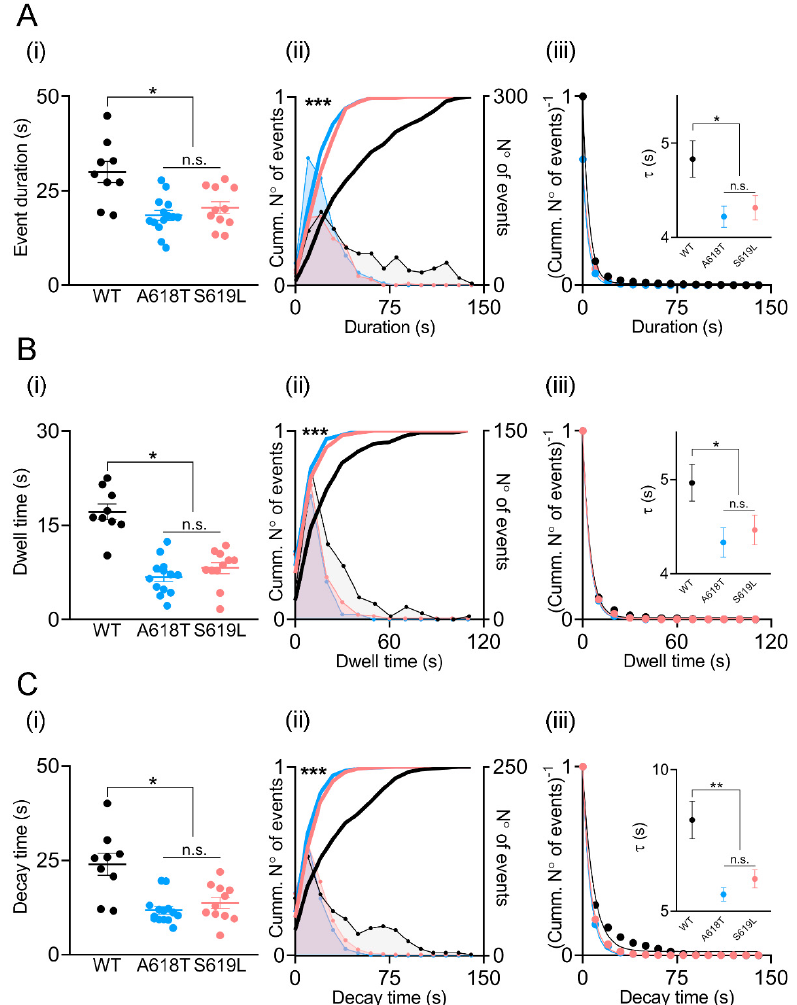
Figure 4. Kinetic parameters in C25 myoblasts overexpressing WT dynamin-2 or the p.A618T or p.S619L mutations. Analysis of event durations, dwell-time lengths and decay times in cells transfected alternatively with WT dynamin-2 (black), p.A618T (blue) or p.S619L (red). Panels (i) show average values of duration ( A ), dwell time ( B ), and decay time ( C ) from individual cells (filled dots) obtained from at least three independent cultures in each condition. Horizontal lines indicate means with SEM. The different conditions were compared by ANOVA test, followed by Bonferroni multiple comparison test * p < 0.05. Panels (ii) show the frequency distribution histograms (lines with dots; 10-s bin widths calculated using the Freedman–Diaconis rule) and its corresponding cumulative histograms (continuous lines) of events obtained during the recording period. The cumulative histograms of mutants vs. the WT condition were compared by the Kolmogorov–Smirnov test, *** p < 0.001. Panels (iii) show the inverse of the normalized cumulative distributions (i.e., survival curves), while insets show the time constants ( τ ) (mean ± SEM) obtained from their fitting to a single exponential decay function. Comparisons of both mutants vs. WT were performed by Student’s t-test with Welch’s correction, * p < 0.05, ** p < 0.01. n.s., non-significant difference.